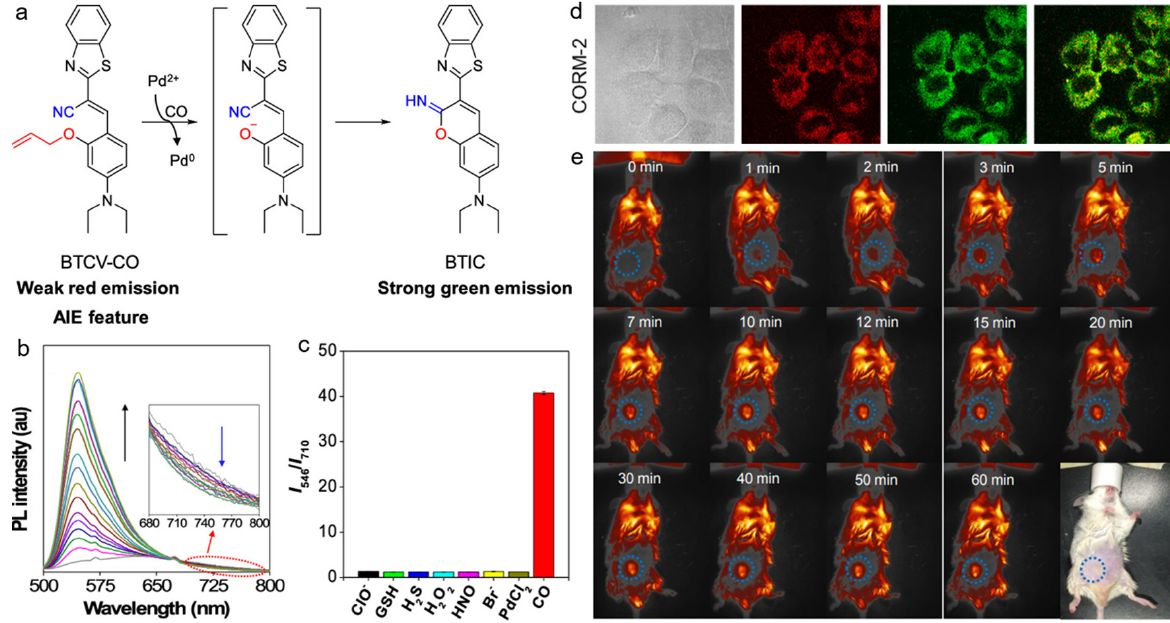
Figure 16. ( a ) The mechanism of AIE-based probe for CO detection; ( b ) PL spectra of BTCV-CO probe incubated with different concentrations of CORM-2; ( c ) PL intensity ratios ( I 546 / I 710 ) of BTCV-CO with the treatment of various biomolecules; ( d ) CL images of MCF-7 cells incubated with the probe; ( e ) in vivo fluorescence imaging of CO with the probe. (Reproduced with the permission from ref. [169]. Copyright 2019, American Chemical Society).